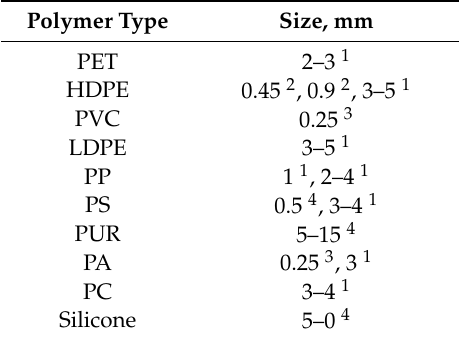
Table 2. Polymer types and sizes of the reference materials used in the library.